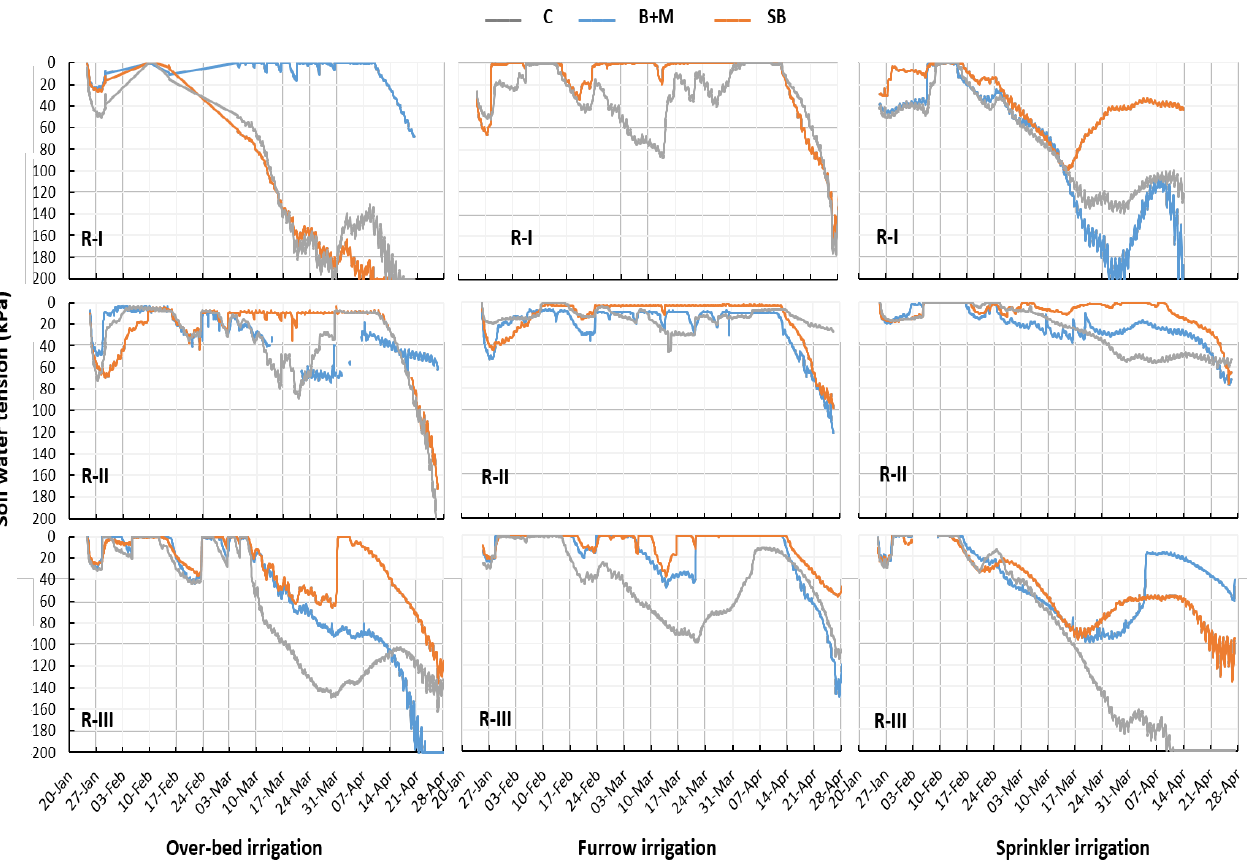
Figure 12. Average soil water tension recorded in each irrigation treatment plot and amendment treatment (control (C), buried rice straw (SB) and biochar plus manure (B + M)). Note that soil water tension for the B + M amendment plot in the first replicate (R-I) of the furrow-irrigated treatment was not included because the sensor showed anomaly readings for the whole growing season.